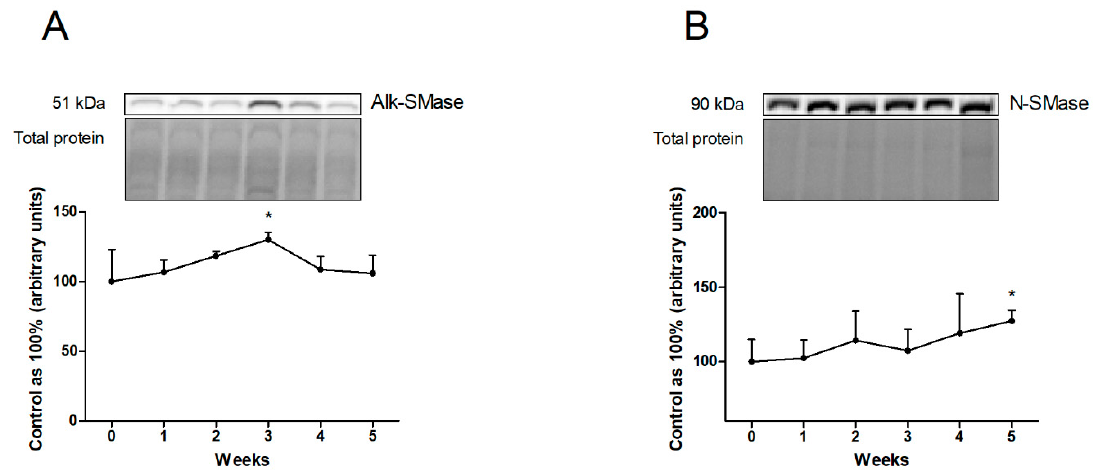
Figure 4. The expression of proteins from the sphingomyelin pathway, i.e., ( A ) alkaline sphingomyelinase (Alk-SMase) and ( B ) neutral sphingomyelinase (N-SMase) in the liver homogenates. The protein expression was measured using the Western blot technique and presented as a percentage difference compared to the control group, which was set as 100%. The data are presented as mean ± SD and based on n = 6 rats per group in each week of the high-fat diet (HFD). * p < 0.05 significant difference vs. control group (0